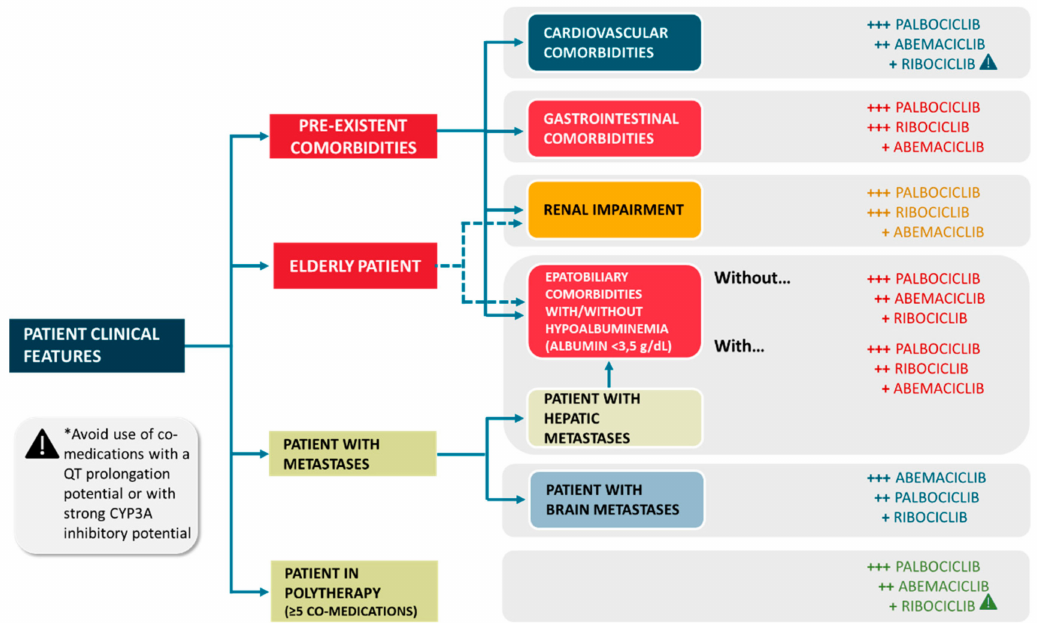
Figure 3. Flow diagram for potential CDKi selection to increase individual safety and tolerability, according to safety data from literature. The CDKi choice of priority is based on each patient’s clinical feature and is arbitrary expressed by: +++ , highly recommended to use; ++ , moderately recommended to use; + , lower recommended to